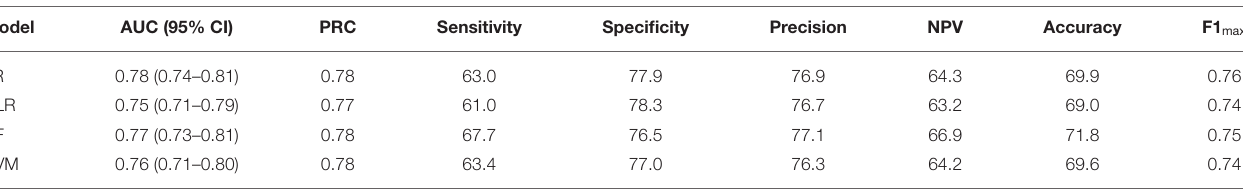
TABLE 4 | Scores for each algorithm of model 2 in derivation cohort.